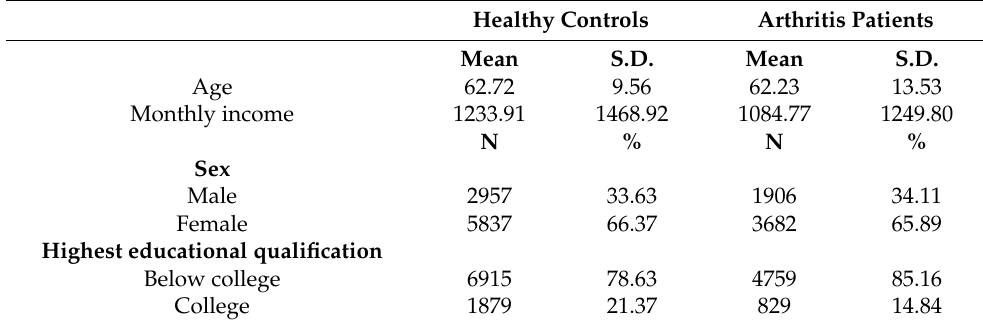
Table 1. The descriptive statistics of demographics in healthy controls and arthritis